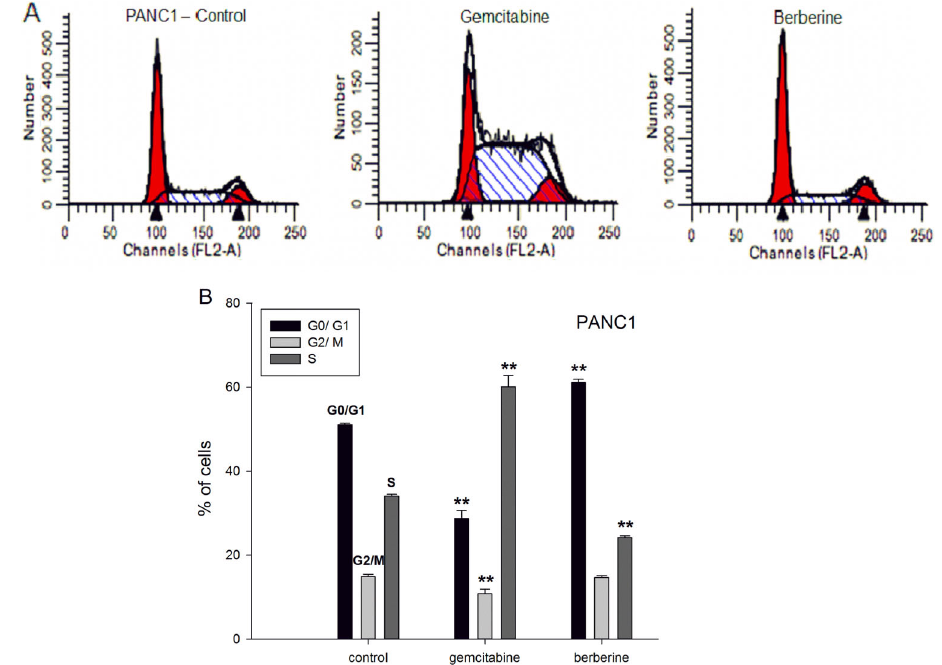
Figure 2. Cell cycle distribution after treatment of PANC-1 with berberine or gemcitabine. PANC-1 cells were treated with distilled water (control), 15 m M berberine, or 10 nM gemcitabine for 72 h. The cell cycle distribution was analyzed by the ModFit LT software and depicted using histograms ( A ) and bar plots ( B ). Cell cycle was analyzed as the percentage of cells at each stage of the cell cycle after DNA staining with PI. Data from a representative experiment (from a total of at least three) are shown. **P , 0.01 versus controls (Student’s t